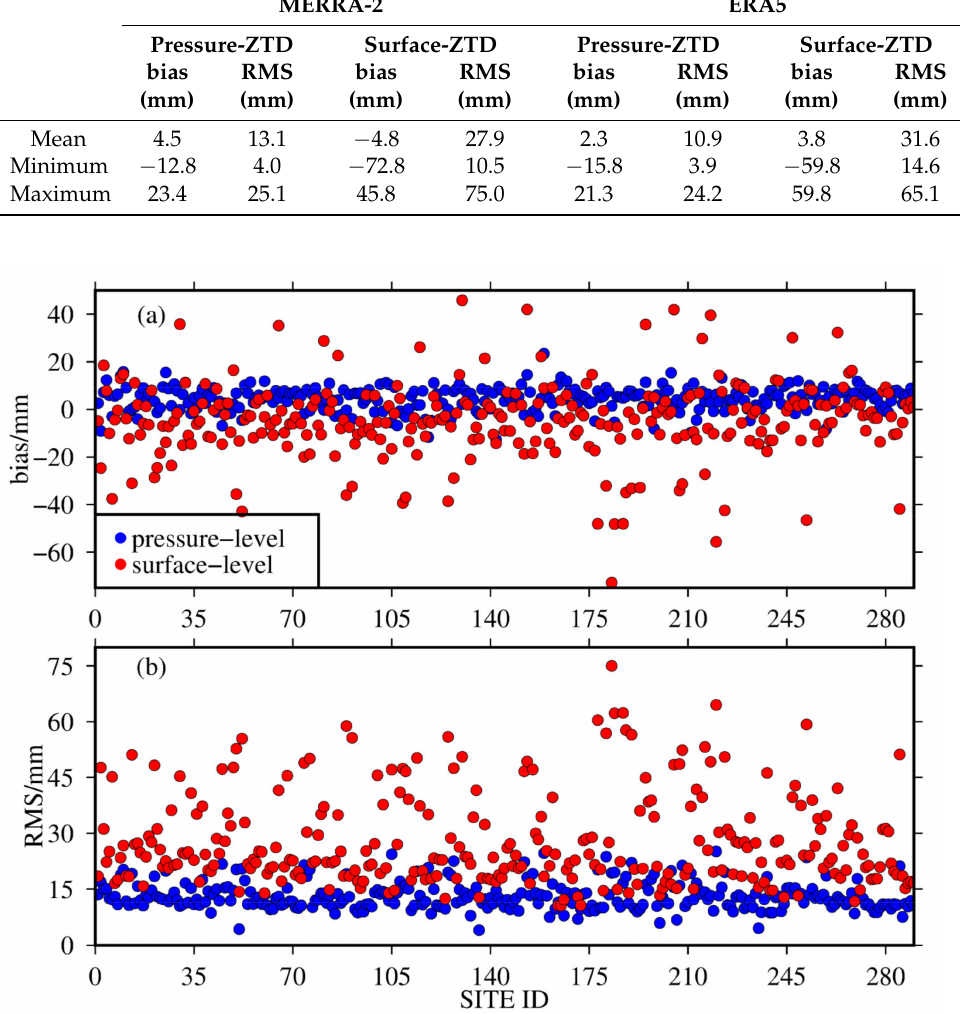
Figure 2. ( a ) Bias and ( b ) RMS of MERRA-2 ZTD from pressure- and surface-level data compared to GNSS ZTD at 290 stations from 2016 to